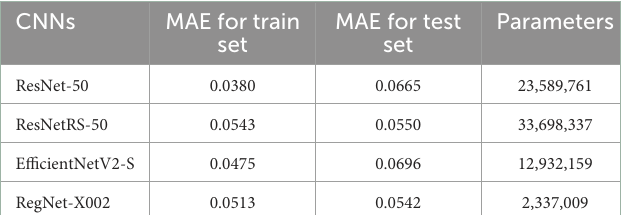
TABLE 3 MAE loss results for ResNet-50, ResNetRS-50, EfficientNetV2-S, and RegNet-X002. Each trial was run a single time and results were taken (n =